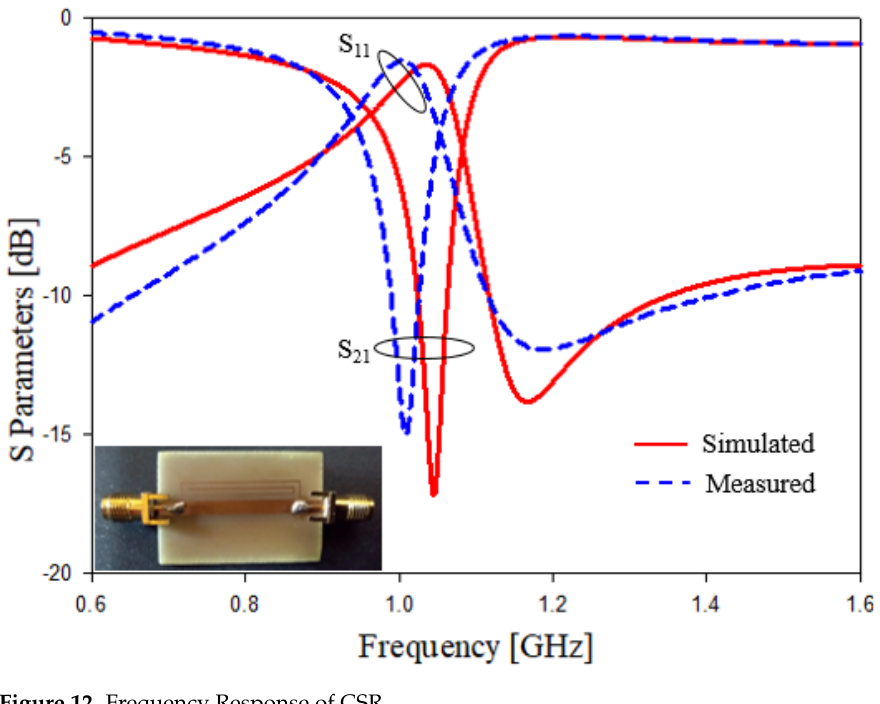
Figure 12. Frequency Response of CSR.